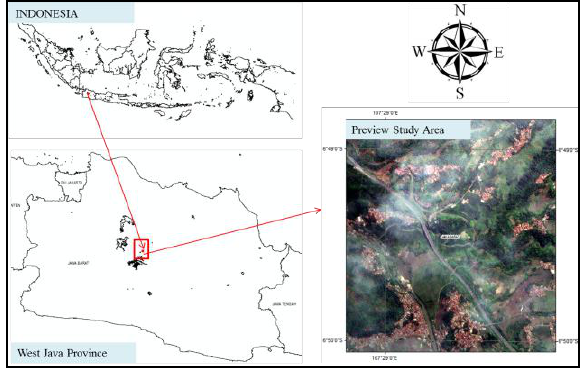
Figure 1. Location of study area